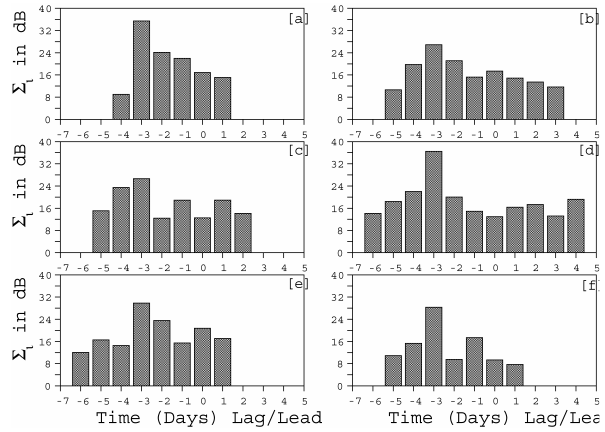
Fig. 3. Examples of some cases where the fluctuation measure 6 i became anomalously high three days prior to the seismic activi- ties. (a) 18 January 2007 ( M = 5 . 8) at Southern Sumatra, Indone- sia; (b) 29 January 2007 ( M = 5 . 2) at north of Camorta, Nicobar; (c) 11 January 2007 ( M = 5 . 6) at off-coast of Sumatra; (d) 19 Jan- uary 2007 ( M = 5 . 4) at southern Sumatra; (e) 20 April 2007 ( M = 6 . 2) at Southwestern Ryukyu Islands, Japan and (f) 24 July 2007 ( M = 5 . 4) at northern